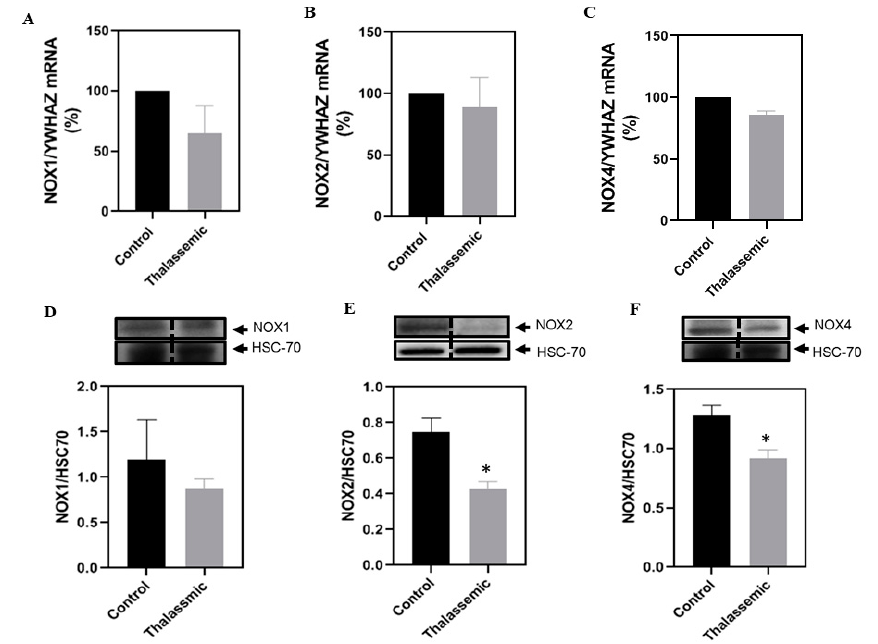
Figure 3. Decreased expression levels of the NOX isoforms in Hbb th3/+ mice. Relative mRNA levels (%) of ( A ) NOX1/YWHAZ, ( B ) NOX2/YWHAZ, and ( C ) NOX4/YWHAZ. Representative Western blot of ( D ) NOX1/HSC70, ( E ) NOX2/HSC70, and ( F ) NOX4/HSC70, with the respective densitometric quantification in liver tissues of control and Hbb th3/+ mice. Values are the means ± SEM from 4 different mice in each group ( n = 4). * p < 0.05 versus control.